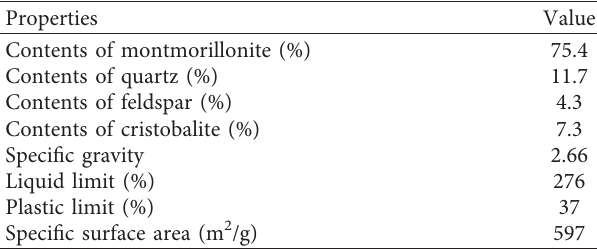
Table 1: Characteristics of the GMZ bentonite (Liu et al.,